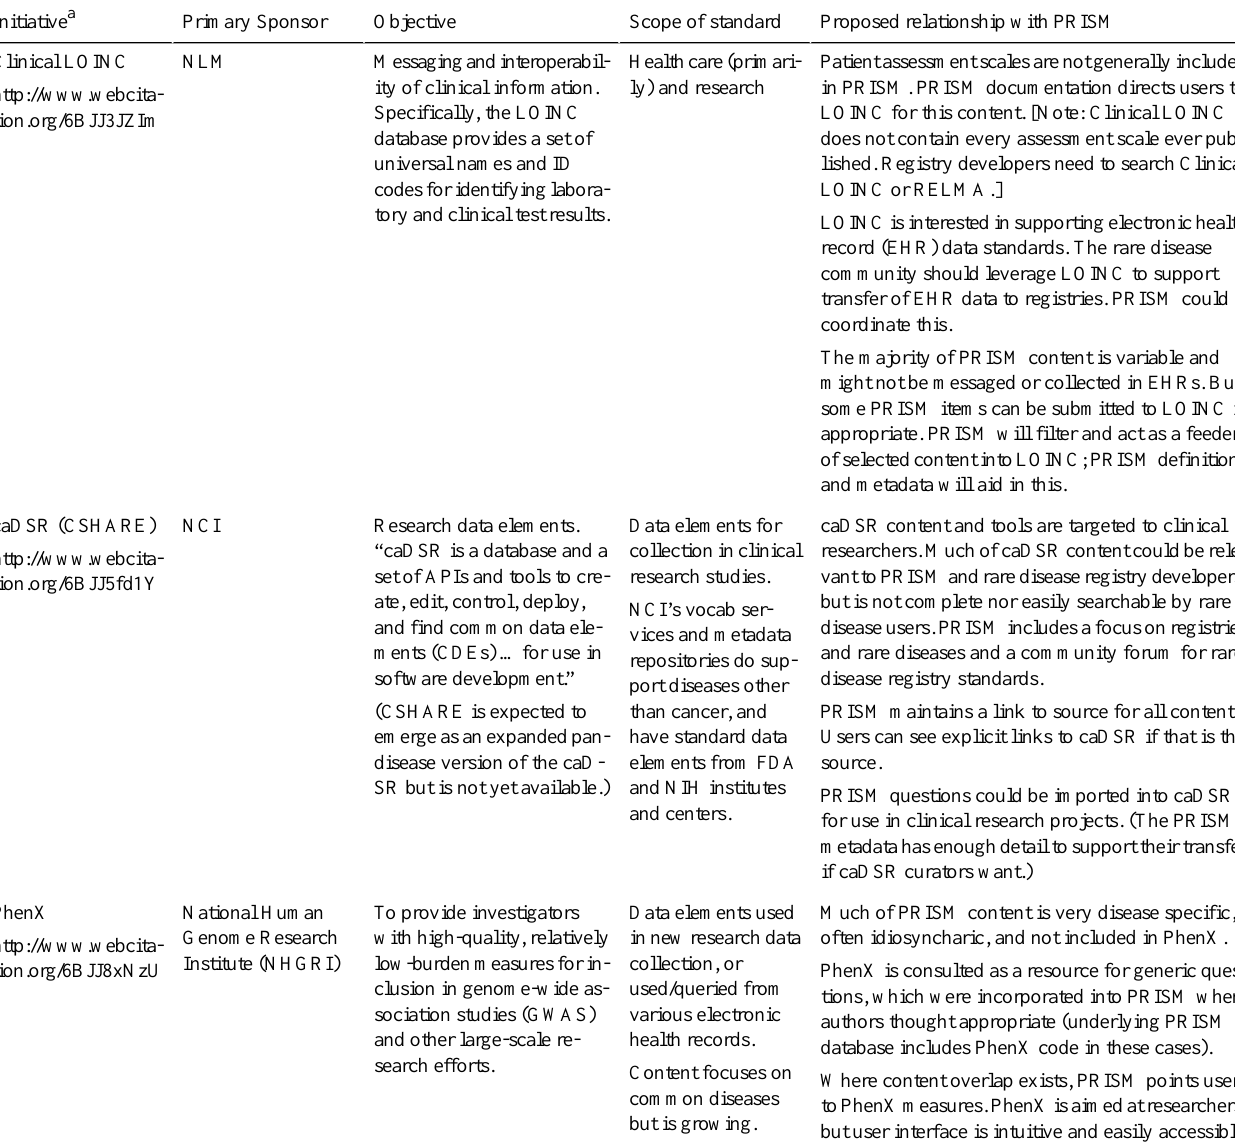
Table 1. Relationship of PRISM to Related Standards Efforts and Resources (LOINC, caDSR, and PhenX).